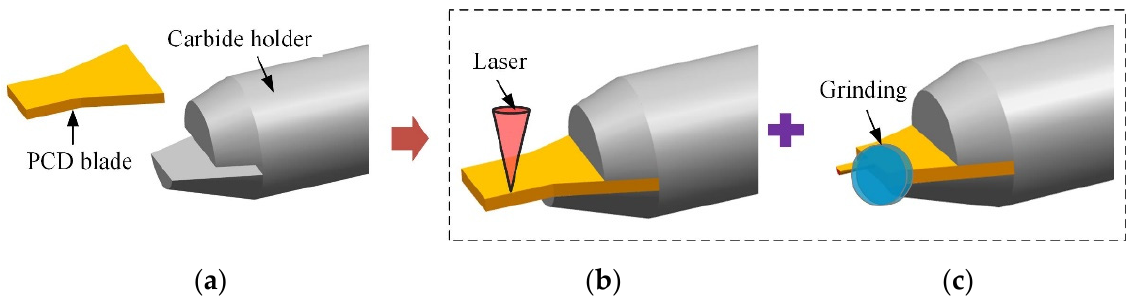
Figure 2. Fabrication scheme of LAR PCD cutter by the hybrid method. ( a ) Blank welding; ( b ) Laser preforming; ( c ) Precision grinding.